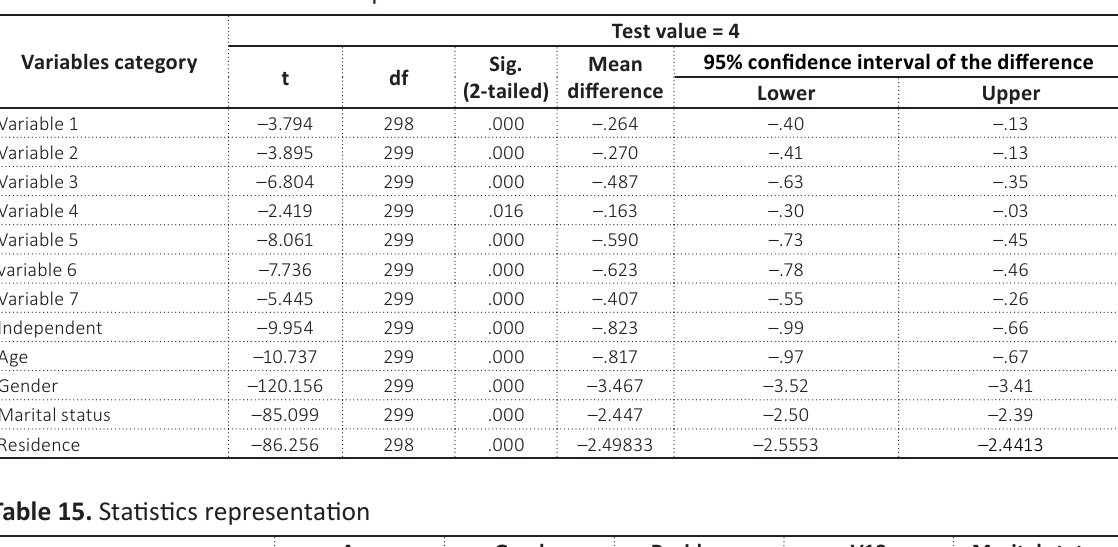
Table 14. Presentation of one sample t -test